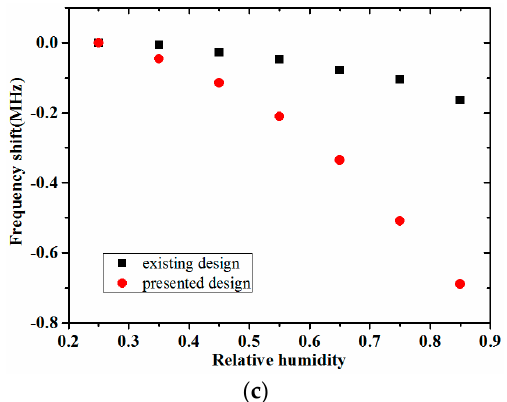
Figure 7. Relative humidity detection results of the FBAR sensor samples: ( a ) resonant peak shifts of the presented sensor and ( b ) random variation of its frequency; ( c ) comparison of the frequency shifts.